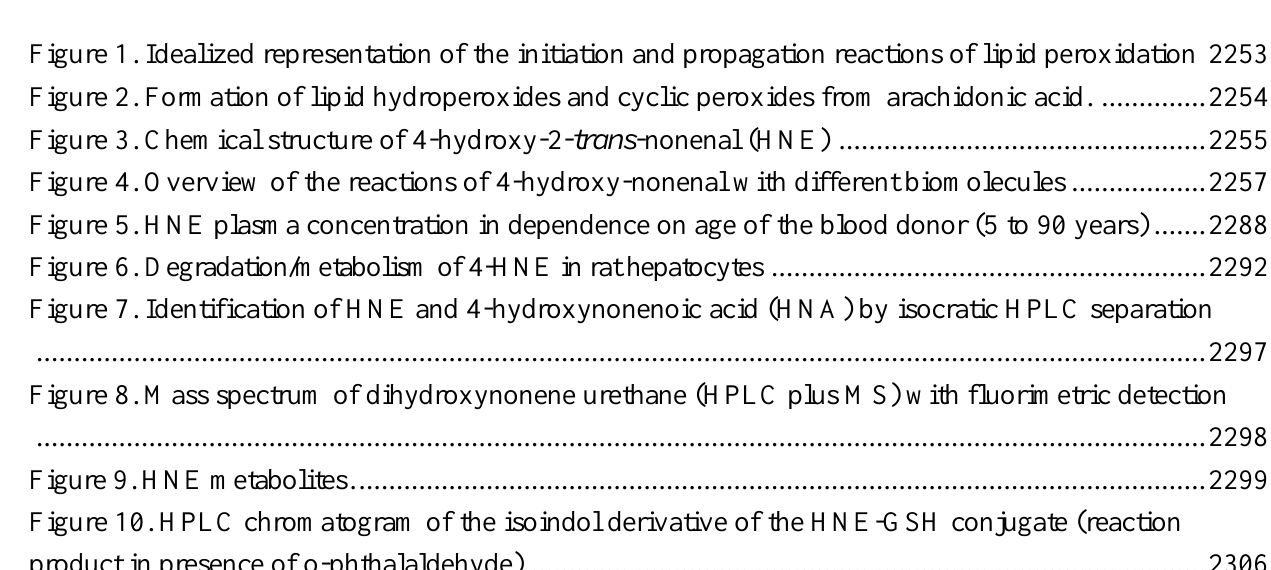
Figure 1. Idealized representation of the initiation and propagation reactions of lipid peroxidation 2253 Figure 2. Formation of lipid hydroperoxides and cyclic peroxides from arachidonic acid. .............. 2254 Figure 3. Chemical structure of 4-hydroxy-2- trans -nonenal (HNE) ................................................. 2255 Figure 4. Overview of the reactions of 4-hydroxy-nonenal with different biomolecules .................. 2257 Figure 5. HNE plasma concentration in dependence on age of the blood donor (5 to 90 years) ....... 2288 Figure 6. Degradation/metabolism of 4-HNE in rat hepatocytes .......................................................... 2292 Figure 7. Identification of HNE and 4-hydroxynonenoic acid (HNA) by isocratic HPLC separation Figure 8. Mass spectrum of dihydroxynonene urethane (HPLC plus MS) with fluorimetric detection Figure 9. HNE metabolites. ................................................................................................................. 2299 Figure 10. HPLC chromatogram of the isoindol derivative of the HNE-GSH conjugate (reaction product in presence of o-phthalaldehyde) ..........................................................................................